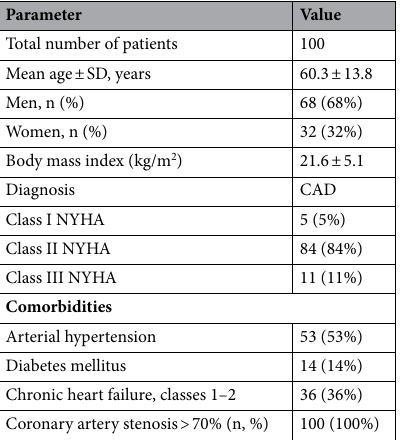
Table 1. Clinical and demographic data of the study